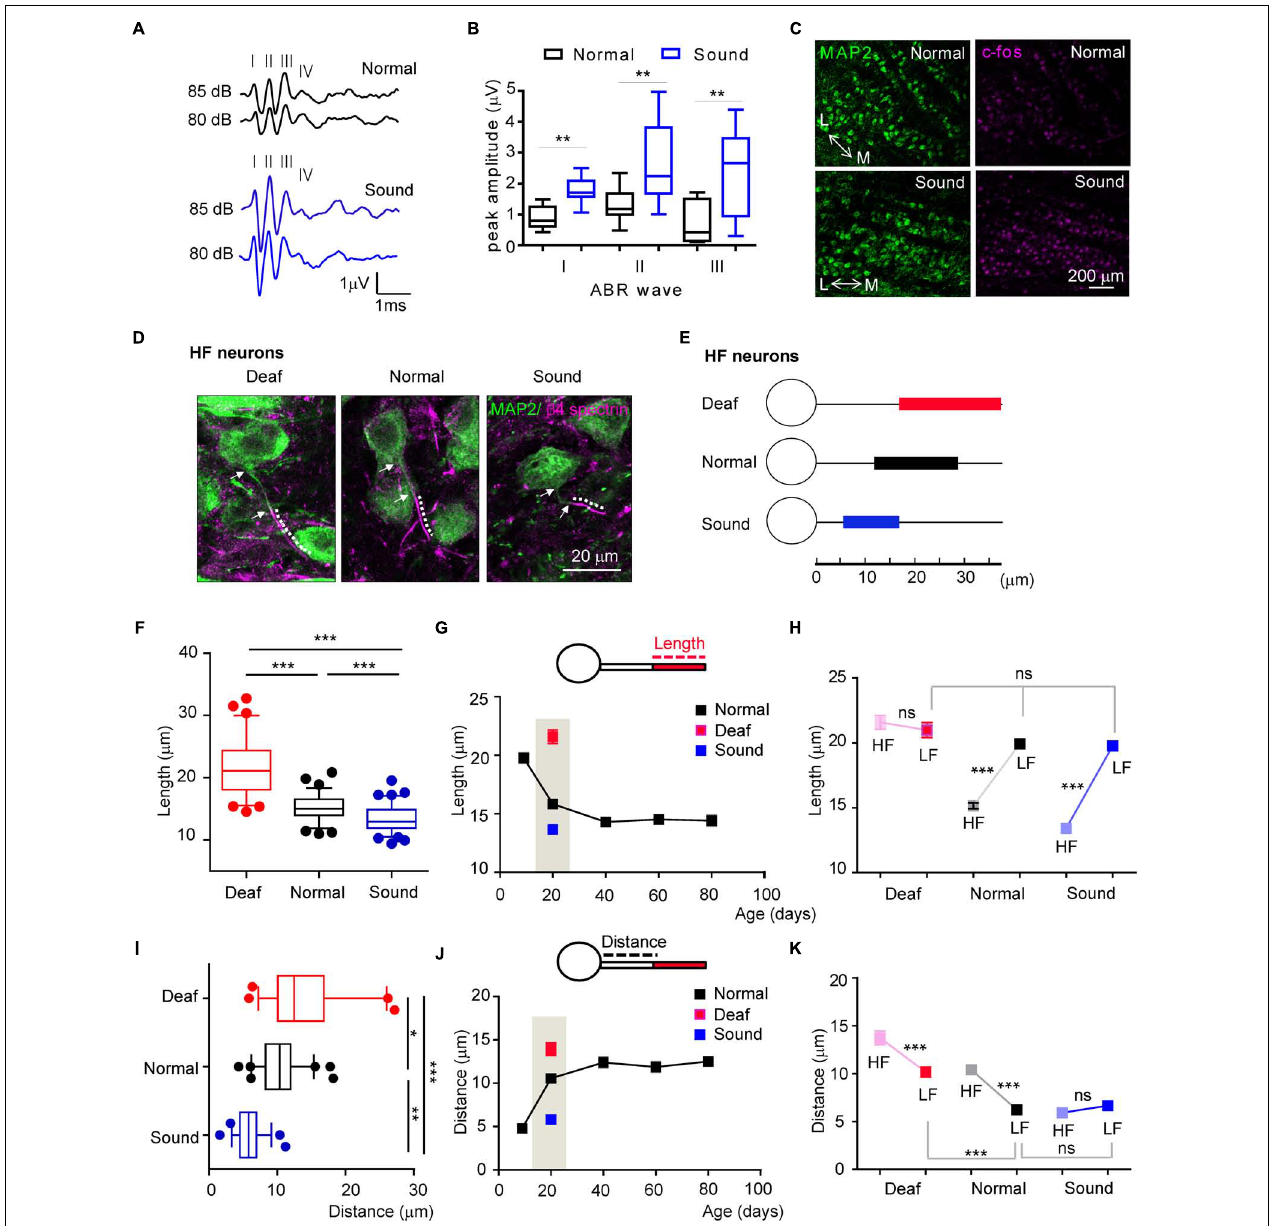
FIGURE 4 | Sound deprivation and stimulation impact developmental refinement of AIS structure, position, and tonotopy in the MNTB. (A) Examples of the ABRs of normal (black) and sound stimulated mice (blue) are recorded in response to a click stimulus of sound (80 and 85 dB). Roman numerals indicate peak waves I to IV (B) Summary of the amplitude of waves I to III in response to click stimulus (85 dB) in normal and sound stimulated mice at P20. ∗∗ p < 0.01, unpaired t -test. (C) Immunostaining of the MNTB with c-fos and MAP2 from normal and sound stimulated mouse with the tonotopic axis (M: medial MNTB, L: lateral MNTB). Note, the number of c-fos positive cells is increased in the MNTB of the sound stimulation group. (D) HF neurons, immunostained with MAP2 and β 4 spectrin from deaf mice (Deaf), age-matched normal hearing mice (Normal), and sound stimulation group (Sound). The dotted line and white arrow indicate AIS length and distance, respectively. (E) Diagram of AIS length and location in HF neurons from Deaf (red), Normal (black), and Sound (blue). (F) Summary of AIS length in HF neurons from Deaf, Normal, and Sound at P20. ∗∗∗ p < 0.0001, one-way ANOVA with Turkey’s multiple comparison test. (G) The plot of AIS length of HF neurons from normal mice from P9 to P80 (black, as shown in Figure 3D ), and those from Deaf and Sound at P20. (H) Tonotopic differentiation of AIS length between HF and LF neurons in Deaf, Normal, and Sound. ∗∗∗ p < 0.0001, Mann–Whitney U test for HF and LF neurons; ns, non-significant, Kruskal–Wallis with Dunn’s post hoc test for AIS length of LF neurons from Deaf, Normal, and Sound. (I) Summary of AIS location, as defined by the distance from the soma, of HF neurons in Deaf, Normal, and Sound at P20. ∗∗∗ p < 0.001, Kruskal–Wallis with Dunn’s post hoc test. (J) The plot of AIS location changes during postnatal development in normal mice from P9 to P80 (black, as shown in Figure 3E ), and those in Deaf and Sound at P20. (K) Tonotopic differentiation of AIS location between HF and LF neurons in Deaf, Normal, and Sound at P20. ∗∗∗ p < 0.0001, either Mann–Whitney U test or unpaired t -test for HF and LF neurons, Kruskal–Wallis test with Dunn’s post hoc test for AIS distance of LF neurons from Deaf, Normal, and